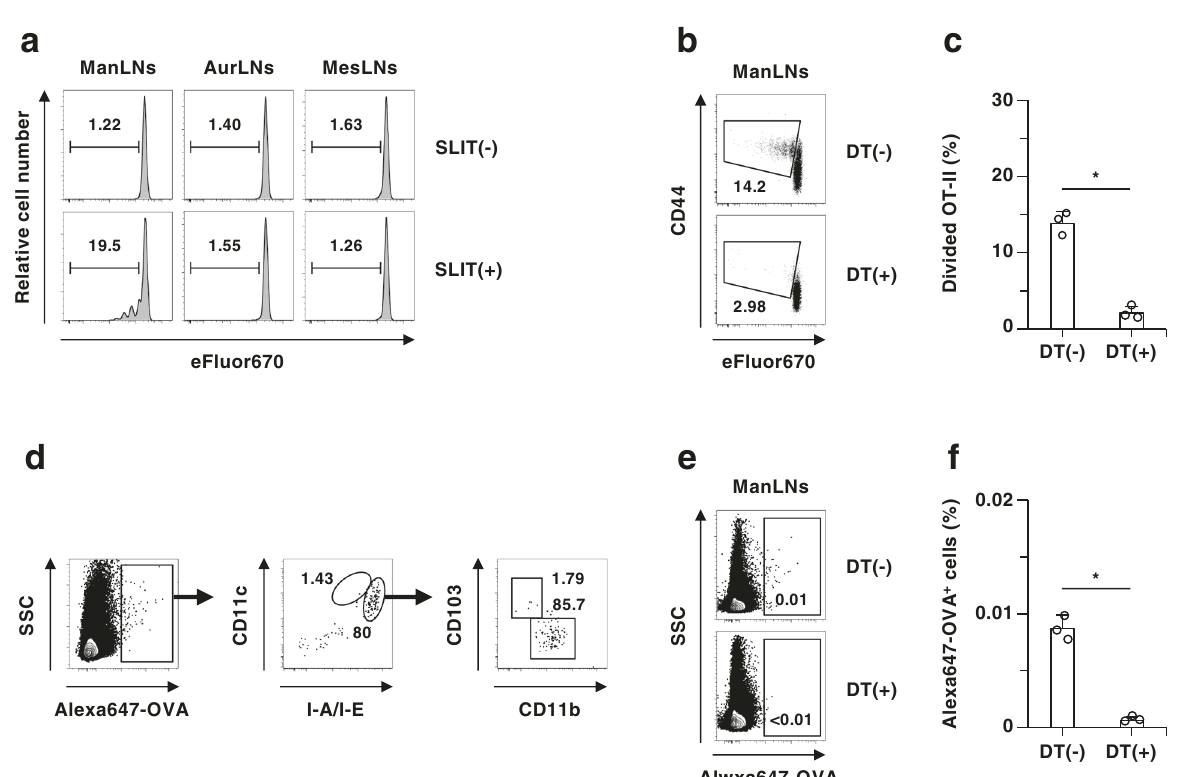
Fig. 3 De fi ciency of cDCs attenuates antigen-speci fi c priming of CD4 + T cells in the draining ManLNs. a – c WT mice a and CD11c-DTR/EGFP mice that had been treated with PBS b , c or DT b , c were adoptively transferred with eFluor ™ 670-labeled CD45.1 + OT-II CD4 + T cells, and then mice were sublingually administered with OVA protein. Cell dividing pro fi le a , b and proportion c of CD45.1 + OT-II CD4 + T cells in ManLNs a – c , AurLNs a , and MesLNs a at 3 days after the administration. d – f WT mice d and CD11c-DTR/EGFP mice that had been treated with PBS e , f or DT e , f were sublingually administrated with AlexaFluor ™ 647-labeled OVA protein. Cell surface expression pro fi le d , e and proportion f of AlexaFluor ™ 647-labeled OVA protein- binding cells among leukocytes in ManLNs at 18 h after the administration. Data are obtained from fi ve individual samples in a single experiment. * P < 0.05 compared with CD11c-DTR/EGFP mice that had been treated with PBS indicated as DT( − ). All data are representative of at least three independent